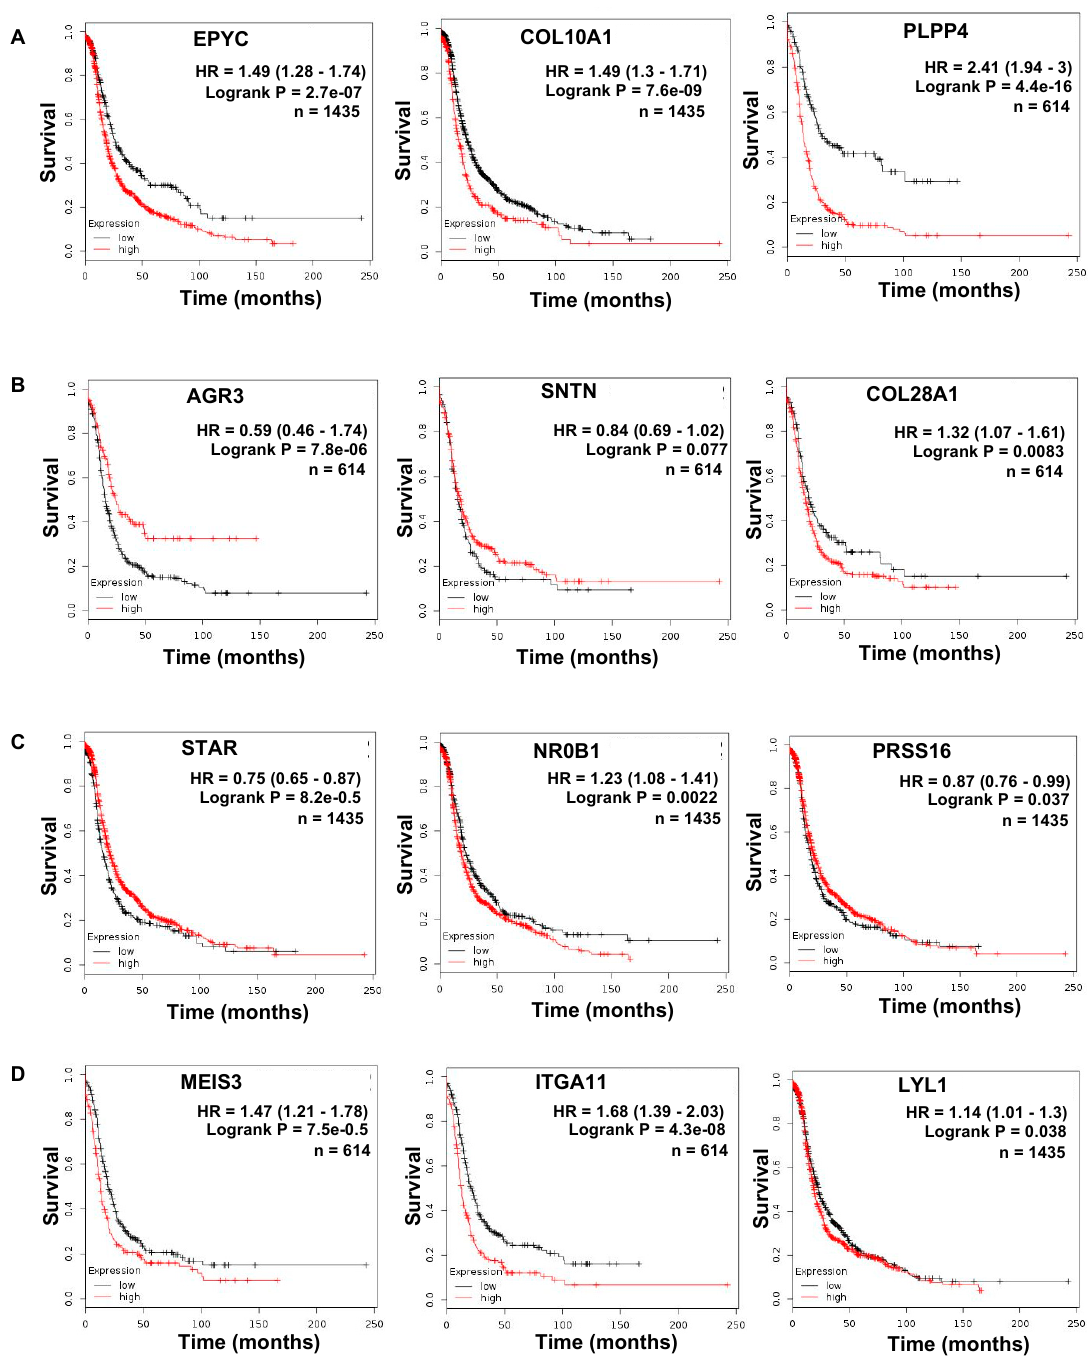
Figure 6. Kaplan-Meier plot for progression free survival analysis for top deregulated genes in both